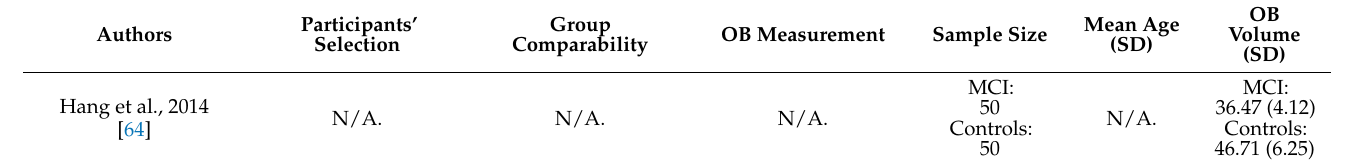
Table 2. Characteristics of studies including patients with MCI in the meta-analysis on OB.